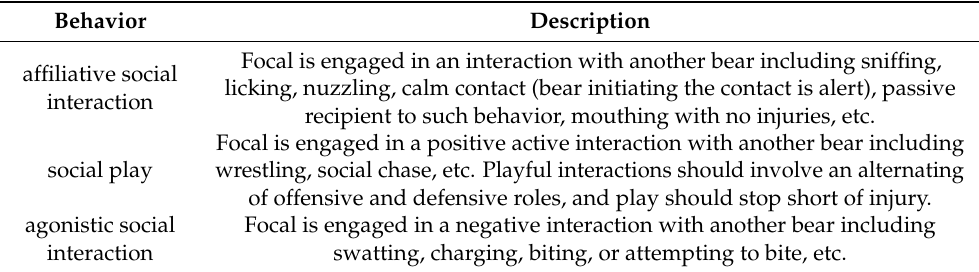
Table 2. Partial ethogram for grizzly bear observations. All behaviors were scored using both scan and all-occurrence sampling. The identity of social partners was also recorded, as was the role of the focal as the initiator or recipient or if the interaction was